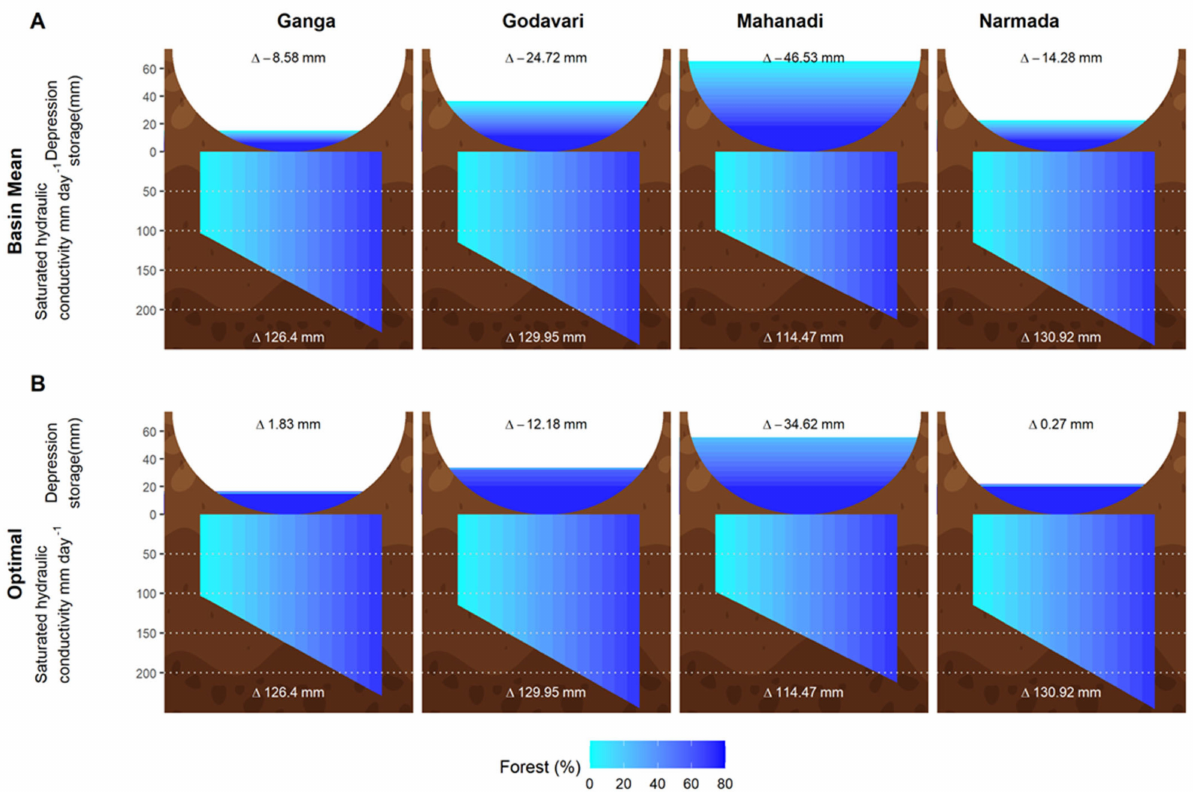
Figure 3. Basin hydrological flux changes over the range of forest cover from 2% to 75%. Evapotranspiration ( A ) shows a linear increase as forest cover increases. The basin mean pathway to increase forest cover ( B ) shows a complex curved relationship of groundwater recharge with increase forest cover. All basins have maximum groundwater recharge near to the current forest cover. Graphs show groundwater recharge for the groundwater recharge optimized pathway. The optimized pathway demonstrates that it is possible to achieve increases to groundwater recharge with increased forest cover at the basin scale depending on the land converted to